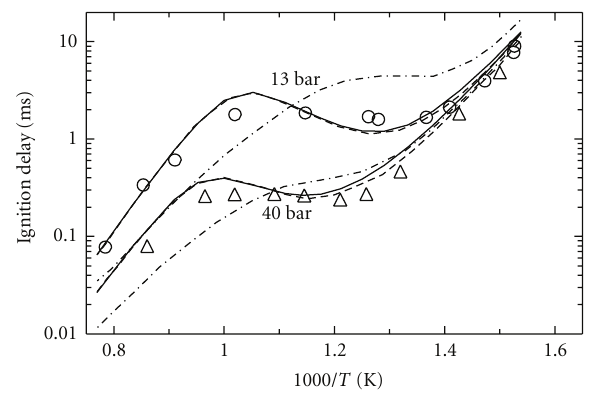
Figure 1: Comparison of computed and measured auto-ignition delay times versus 1000/T (K). Symbols: shock tube data [1] (cid:2) : 13bar : 40bar; Solid Lines: detailed mechanism by Zhao et al. (cid:0) [10]; short dashed lines: 28-species reduced chemistry (this work); long dot-dashed lines: 26-species skeletal mechanism by Yao et al. [14,